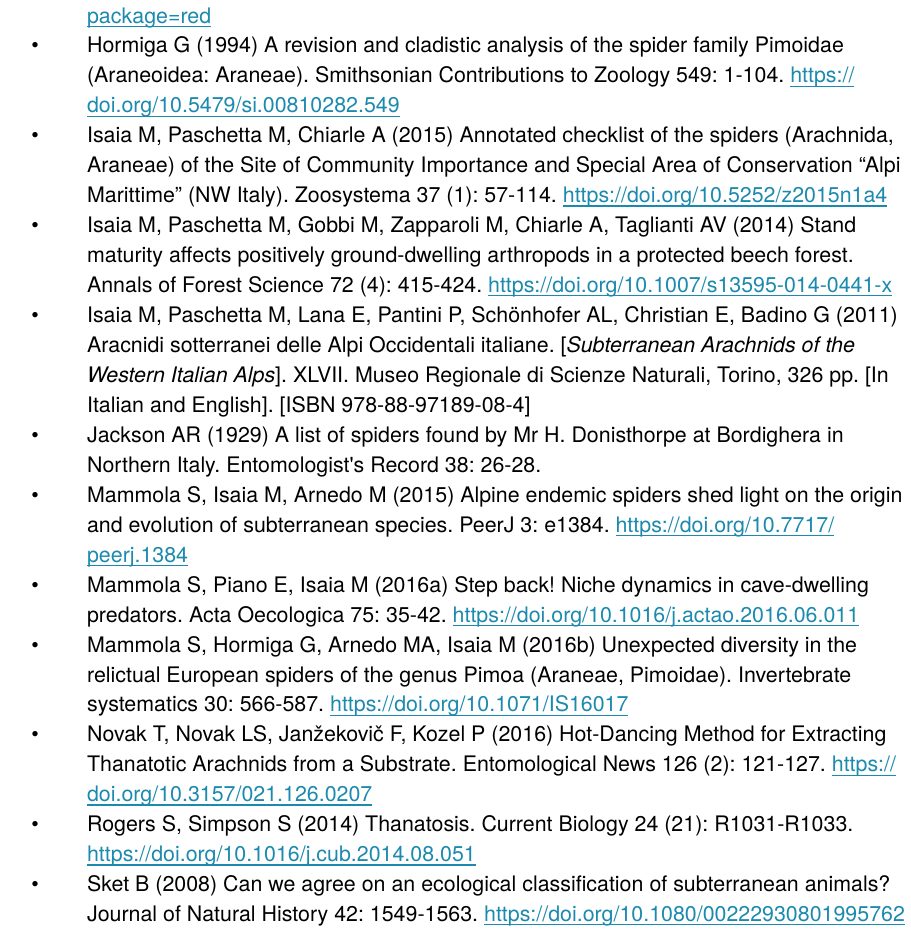
Suppl. material 1: Extent of Occurrence of Pimoa